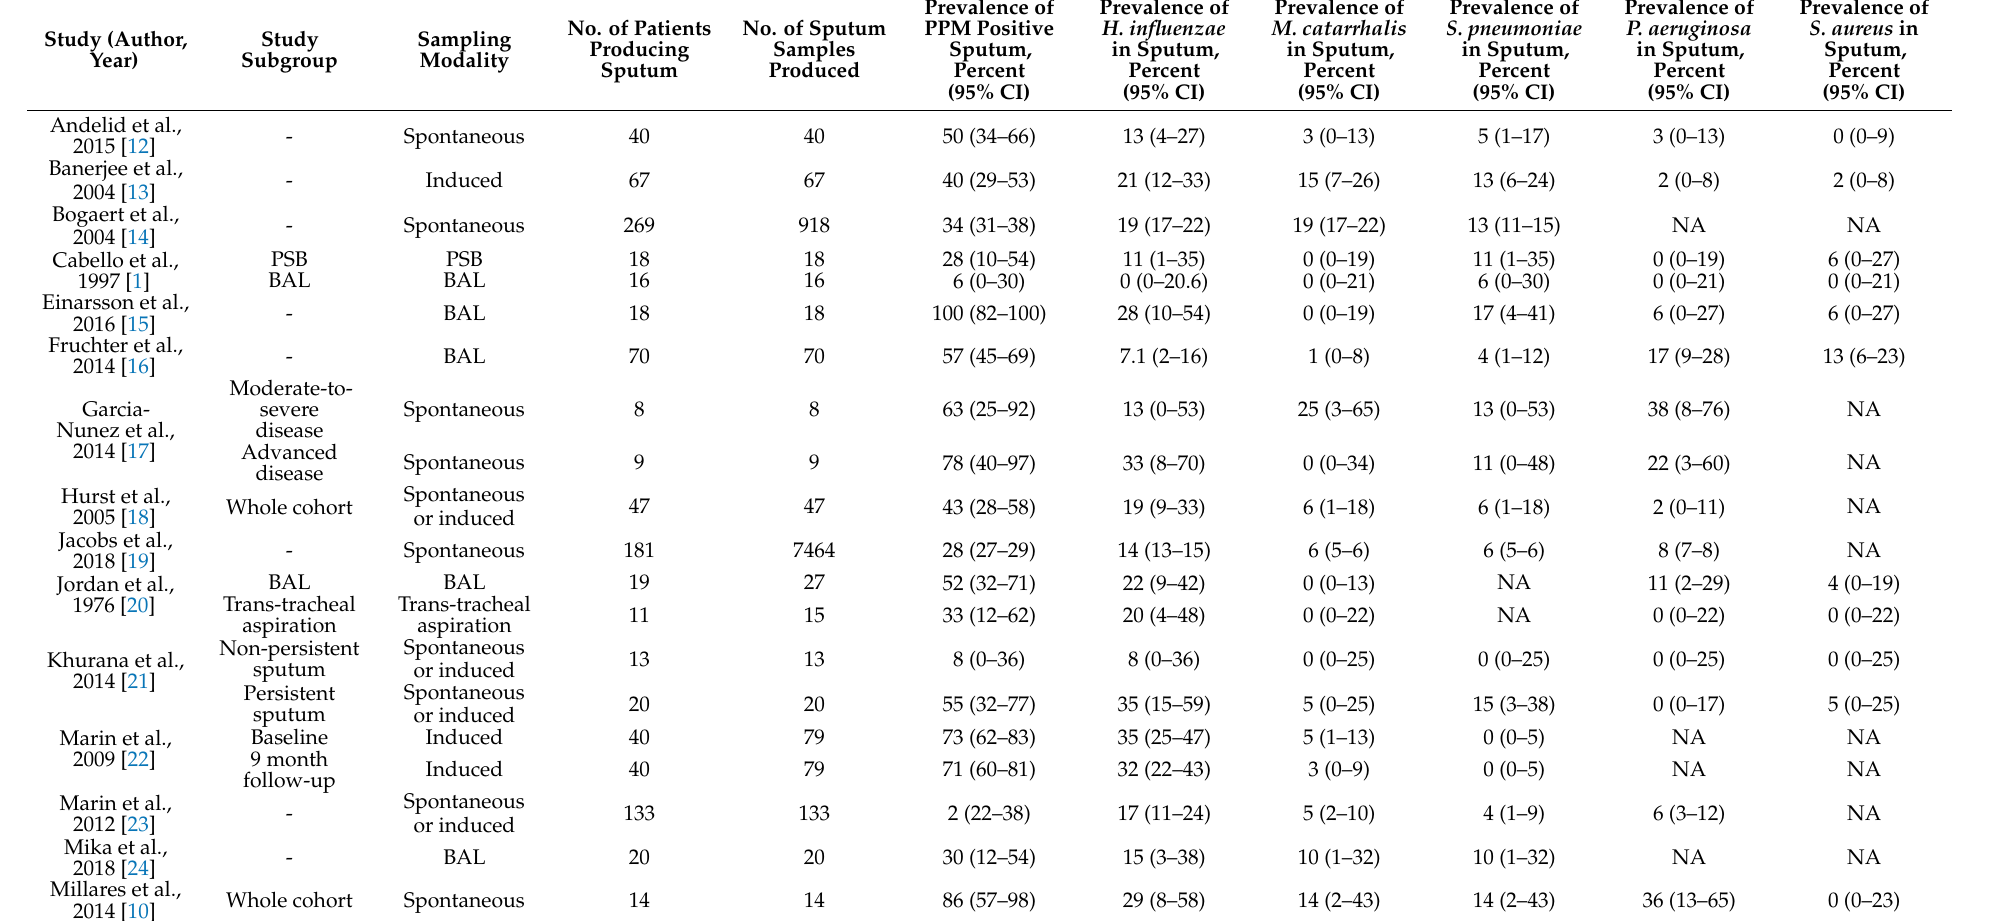
Table 3. Sputum culture outcomes and prevalence of top five most commonly reported